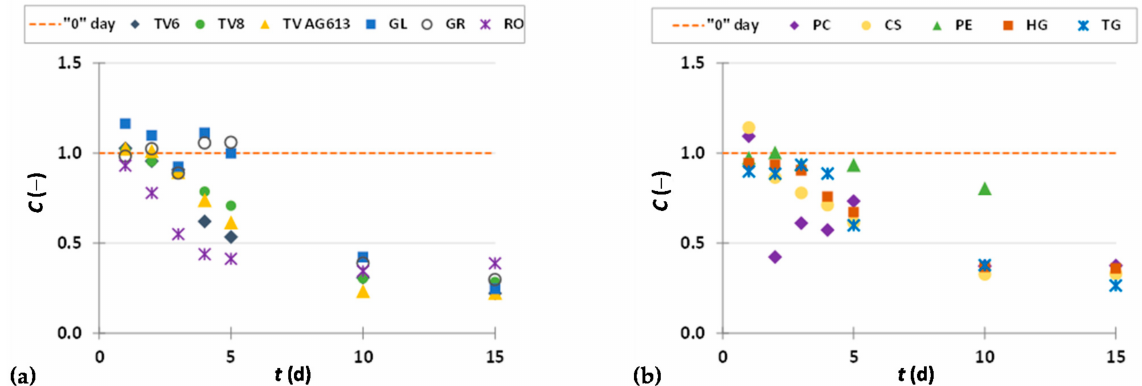
Figure 6. Dimensionless content ( C = C i / C o ) of ferulic acid in GP extracts before biological treatment (‘0’ day) and after 1–15 days of biological treatment with TV6, TV8, TV AG613, GL, GR, RO ( a ), and PC, CS, PE, HG, TG ( b ).